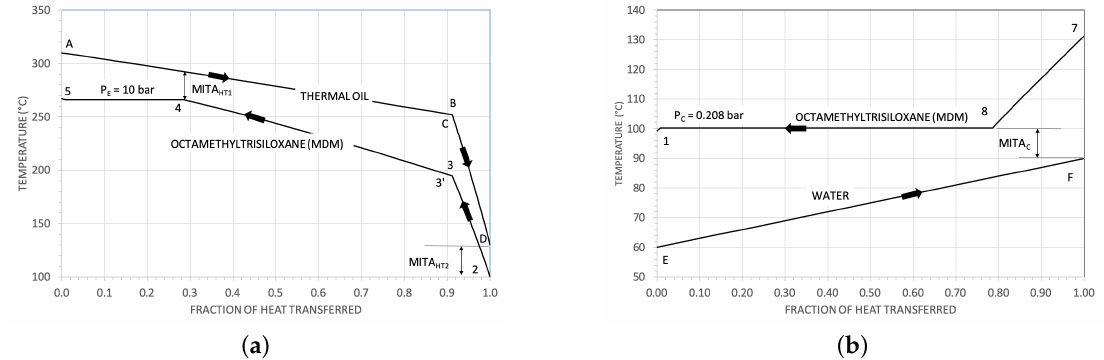
Figure 4. T − ˙ Q diagrams for the reference case. ( a ) T − ˙ Q diagram for the oil heat exchangers HT 1 and HT 2 . The mass flow rates of the hot oil are different in the two heat exchangers HT 1 and HT 2 . So, from the point C on, the slope of the temperature changes. ( b ) T − ˙ Q diagram for the